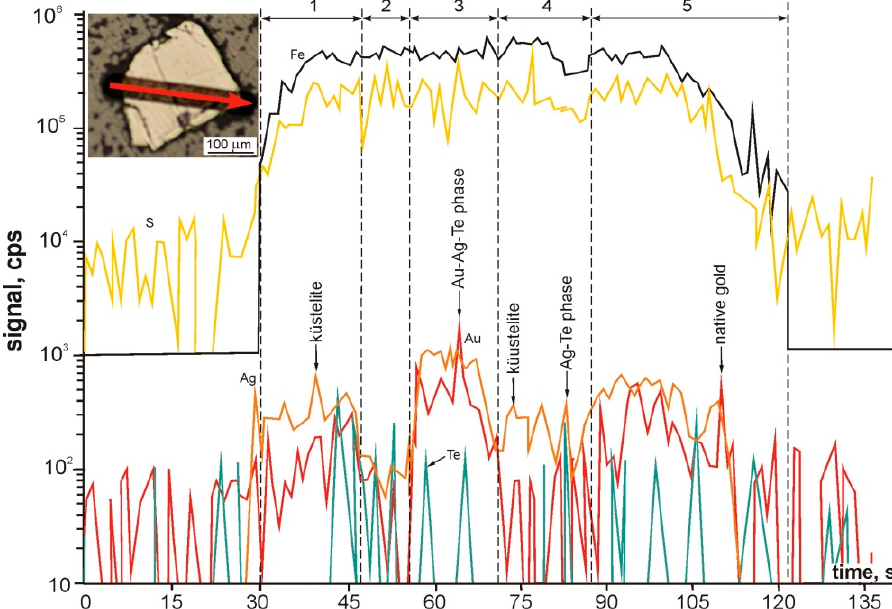
Figure 19. Composition of pyrite of the gold-sulphide assemblage from the Petropavlovsk deposit, LA-ICPMS profile (sample PP 309/10). Submicron inclusions of native gold, küstelite and hessite are probable. For average content of elements in the profile intervals, see Table 9. Table 9. Average concentration of Au, Ag and Te (ppm) in the zones of the pyrite grain. Chemical